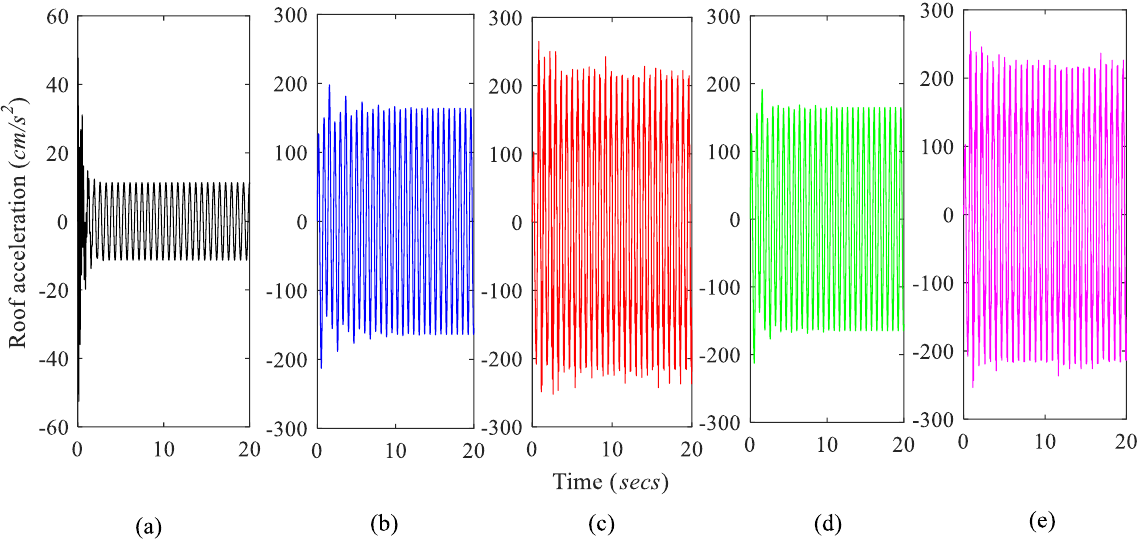
Fig. 14. Time history of roof acceleration of (a) Fixed base (b) Isolated base with LRB (c) Isolated base with LPB (d) Isolated base with LRB and TMD (e) Isolated base with LPB and TMD structures under wind load causing yielding of LPB.